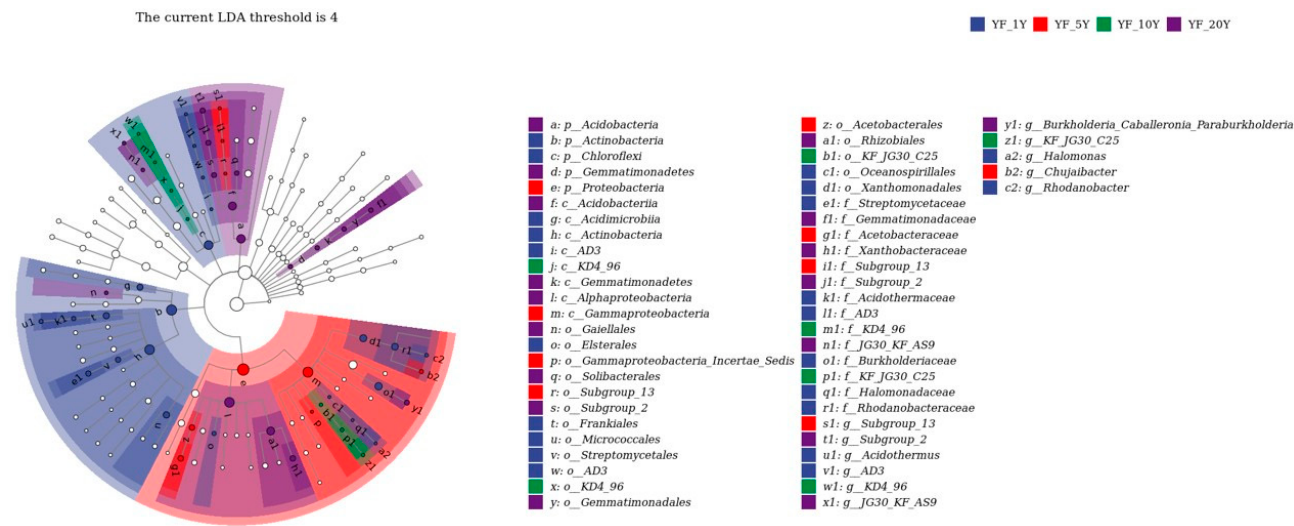
Figure 4. The LEfSE analysis of differences in bacterial abundances among different treatments with a threshold value of 4.0. The taxonomic clades map showed the taxonomic rank relationships of the major taxa in the sample community from phylum to genus (from inner circle to outer circle). Node size corresponds to the average relative abundance of the taxon. Hollow nodes represent taxon with no significant differences between groups, while nodes with other colors (blue for YF_1Y, red for YF_5Y, green for YF_10Y, and purple for YF_20Y) indicate that these taxa showed significant differences between groups, and their abundance was higher in the grouped samples represented by this color. Letters identify taxon names that differed significantly between groups.